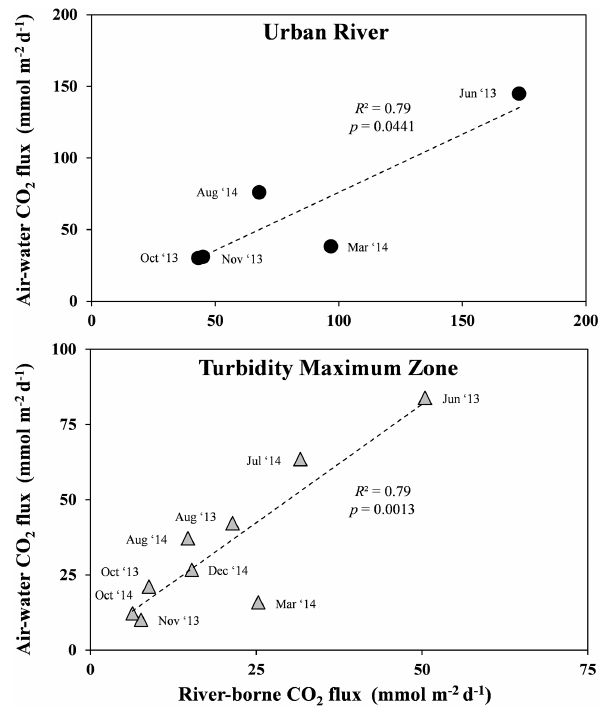
Figure 9. Air–water CO 2 fluxes against river-borne CO 2 fluxes in the urban river and turbidity maximum zone of the Delaware Estu- ary. Note the different axes used for the urban river and turbidity maximum zone.